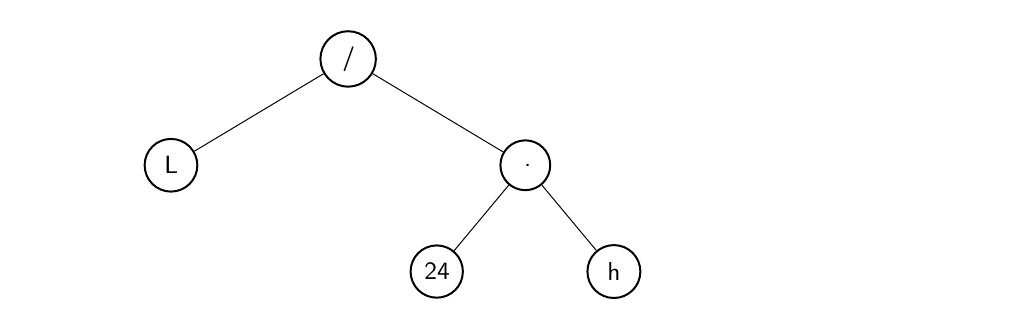
Figure 3. This figure shows how the infix notation for L/(24.h) would look like if expressed in a binary tree. The tree itself was generated by evaluating the respective reverse polish notation.